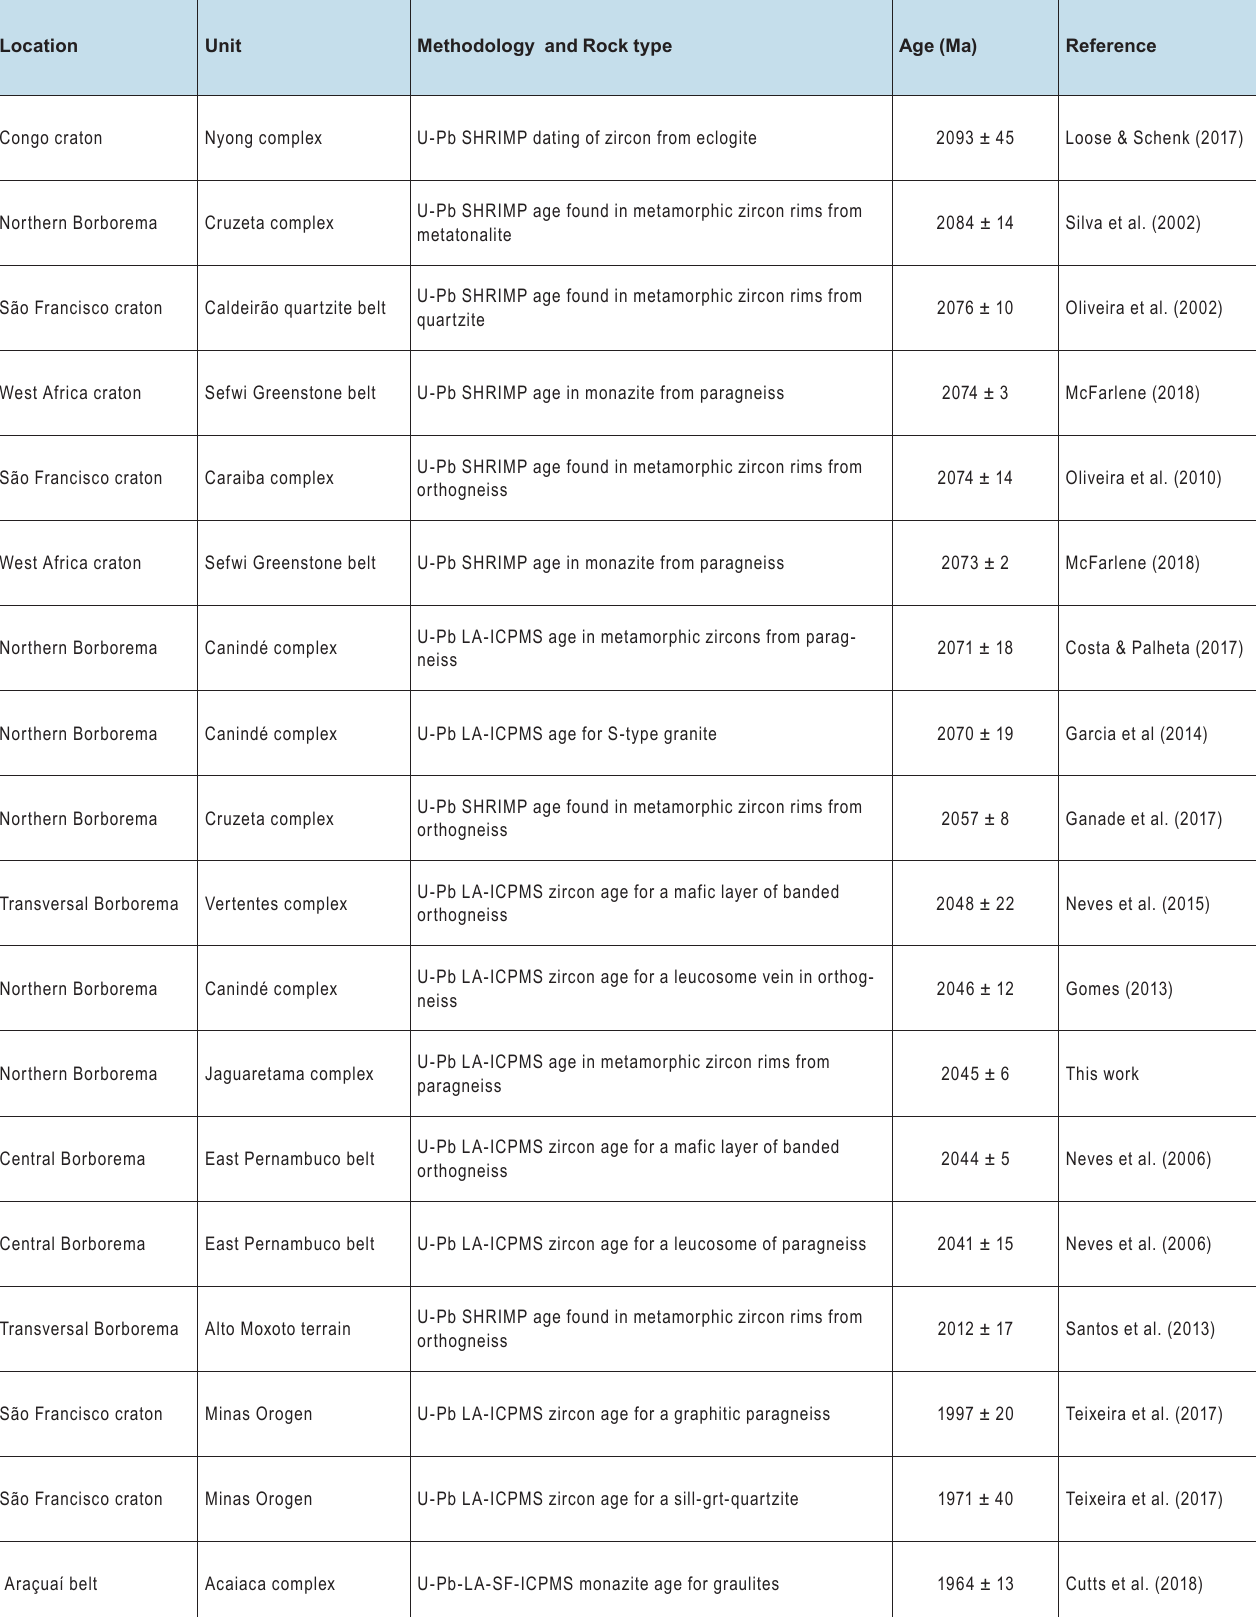
Table 2 – Paleoproterozoic high-grade metamorphic records at the Borborema Province and surrounding cratonic domains.